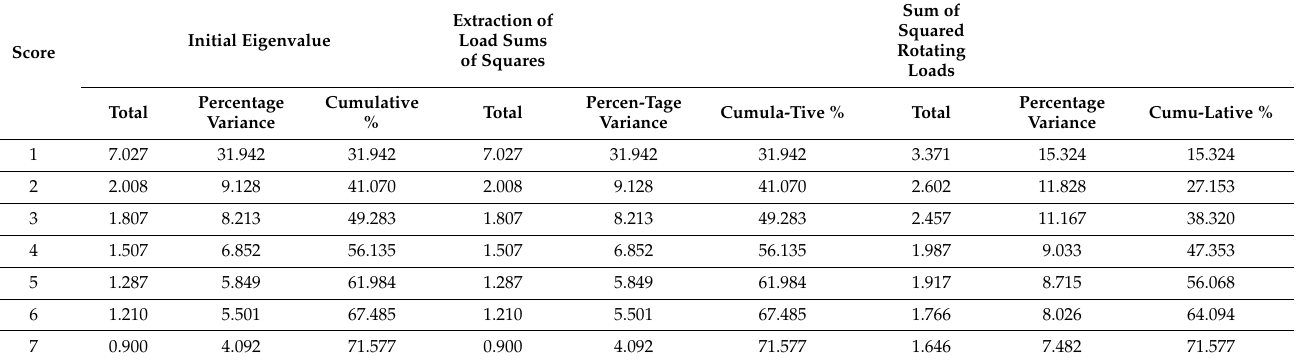
Table 5. Total variance explanation table.